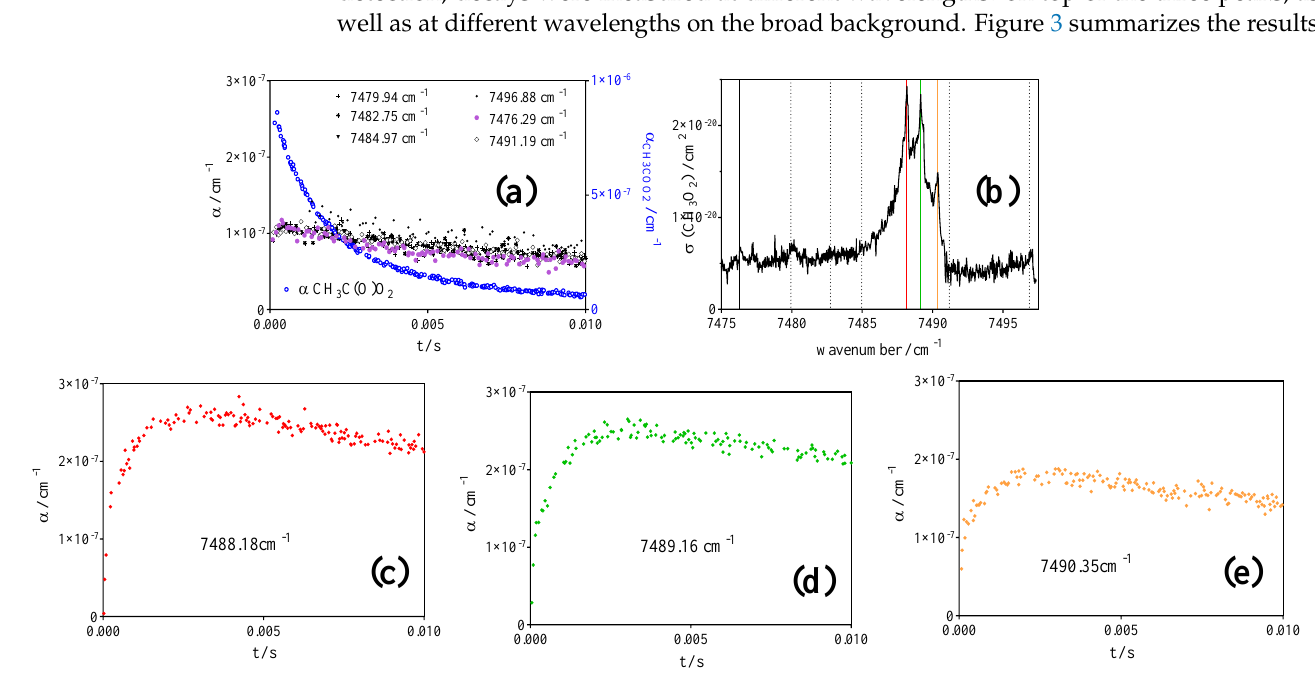
Figure 3. Absorption spectrum of CH 3 O 2 • , adapted from Farago et al. [50] ( b ) and kinetic decays taken following the 351 nm photolysis of [Cl 2 ] = 4.5 × 10 15 cm − 3 in presence of [CH 3 CHO] = 1.66 × 10 15 at a total pressure of 50 Torr helium ([O 2 ] = 3 × 10 17 cm − 3 ). ( c – e ) show the decays taken at the three peaks of the spectrum, ( a ) shows all decays taken at background wavelengths, indicated by vertical dashed lines in the spectrum. The decay of CH 3 C(O)O 2 • is given for information as blue circles in graph a. (right y -axis applies).